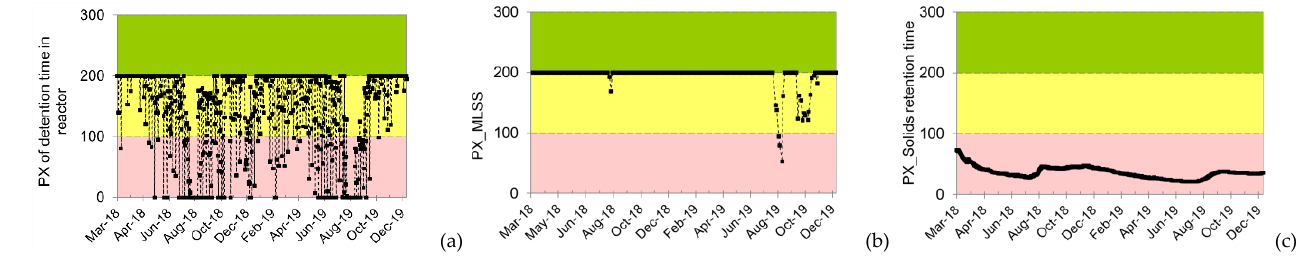
Figure 9. The performance indices of detention time ( a ), MLSS ( b ), and solids retention time ( c ), in the AS reactor of WWTP K.